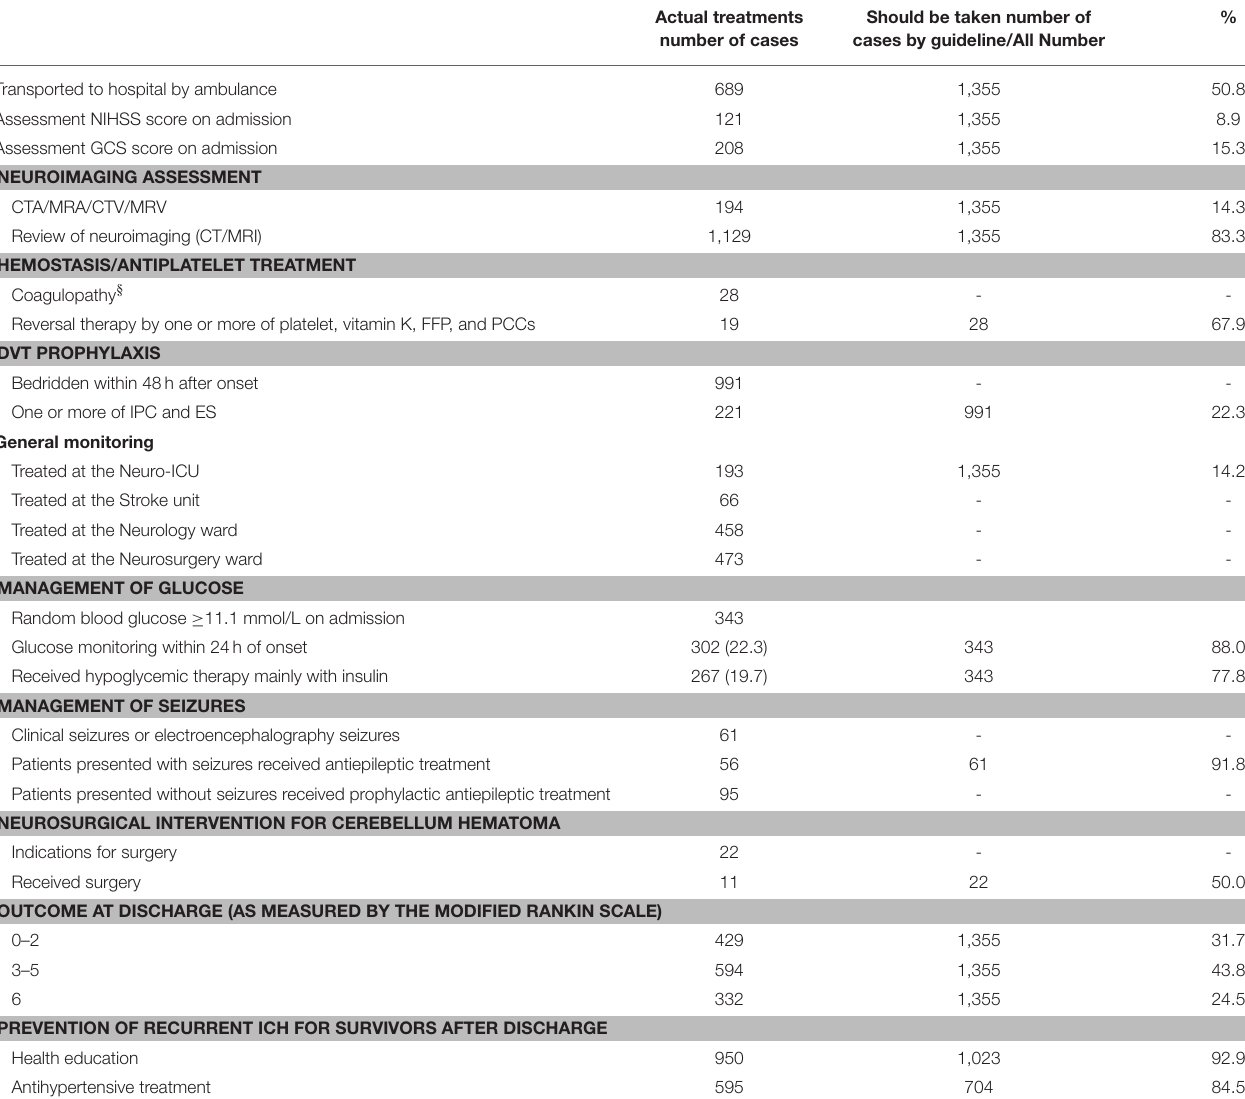
TABLE 2 | In-hospital management and outcomes of ICH patients.